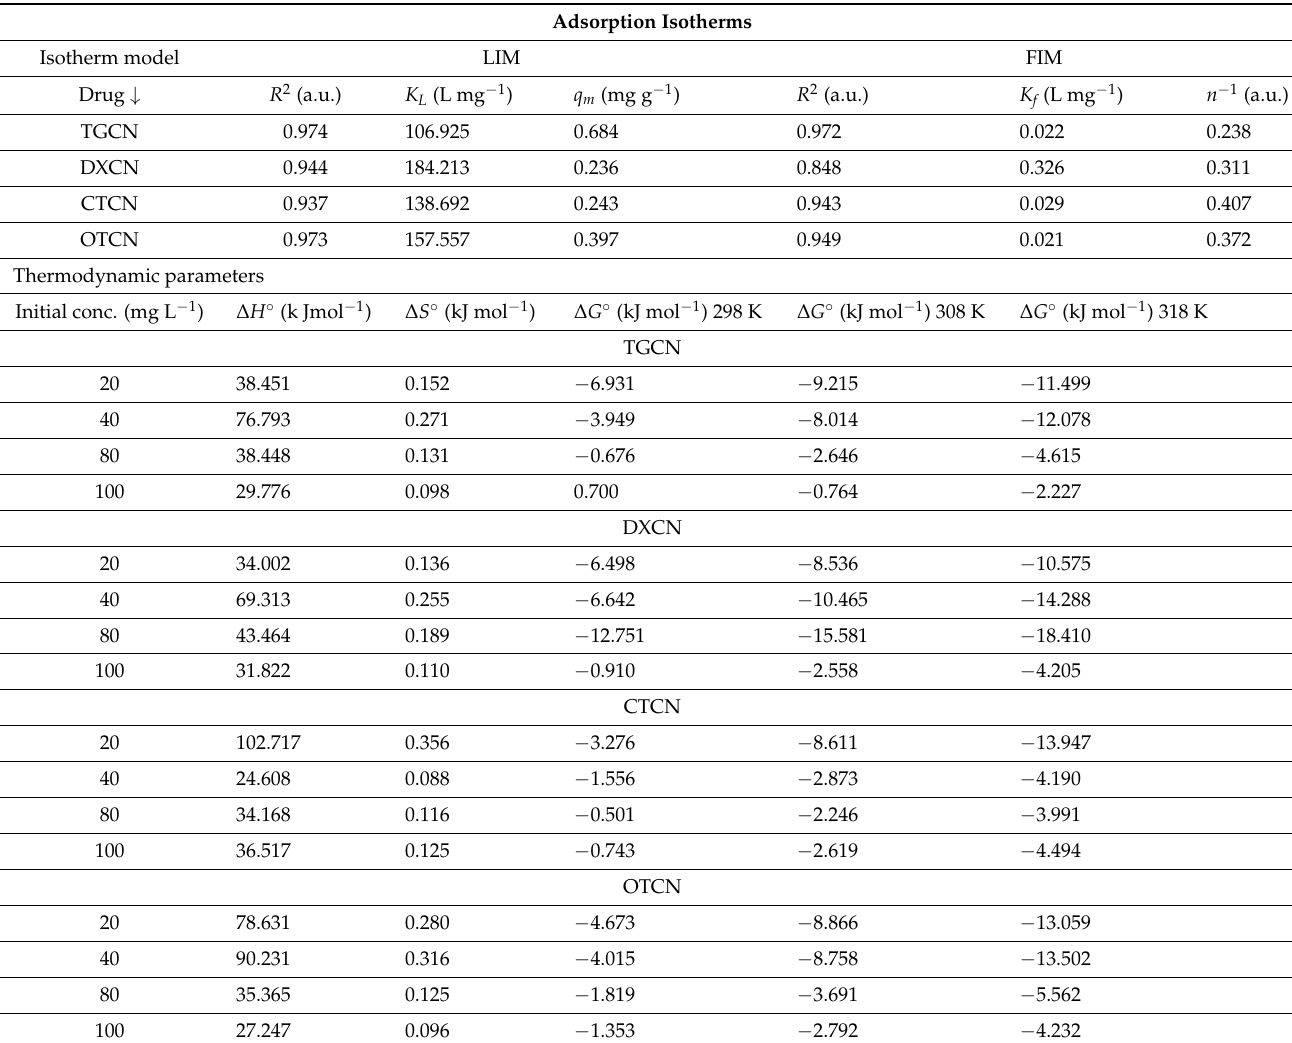
Table 2. The isotherms and thermodynamic results for the adsorption of TGCN, DXCN, CTCN, and OTCN on the synthesized